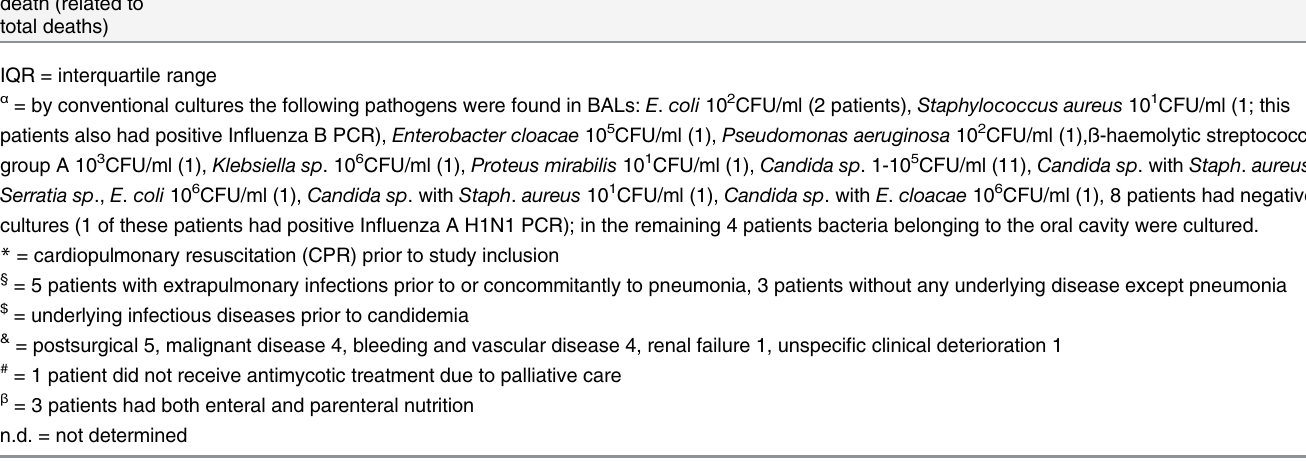
blood cultures from group 4 patients and comprised invasive Candida strains. Candida suscep- tibility testing revealed one Anidulafungin resistant Candida albicans isolate with homozy- geous FKS S645F mutation. MLST was performed with randomly selected 44 isolates, comprising 17 orally colonizing isolates from group 1a and 22 invasive isolates obtained from blood cultures (group 4) as well as 2 oral samples from 2 candidemic patients. Three isolates did not provide adequate PCR results and were excluded from analysis (1 oral colonizing and 2 invasive isolates). There was no difference in distribution of invasive and colonizing isolates in different clades as determined by eBURST, neighbour joining or UPGMA analysis (Fig 1). Since there was no putative invasive Candida clade further MLST typing including Candida spp . from LRT samples was omitted. Table 2. Candida positive cultures from the oral cavity, lower respiratory tract (LRT), and the Candida colonization index. Candida cultures 1a, healthy adults, Oral cavity